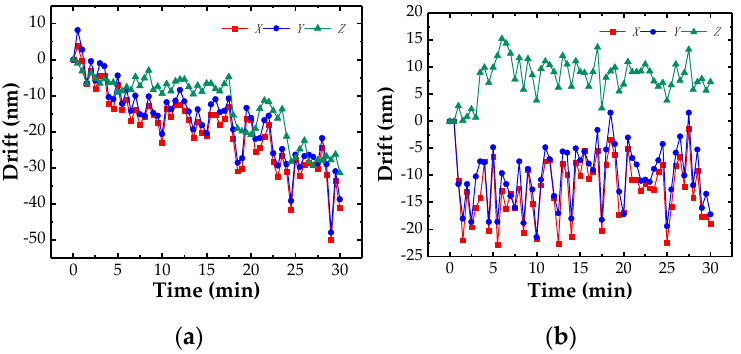
Figure 10. Drifts of the probe: ( a ) the temperature was not controlled; ( b ) the temperature was controlled.